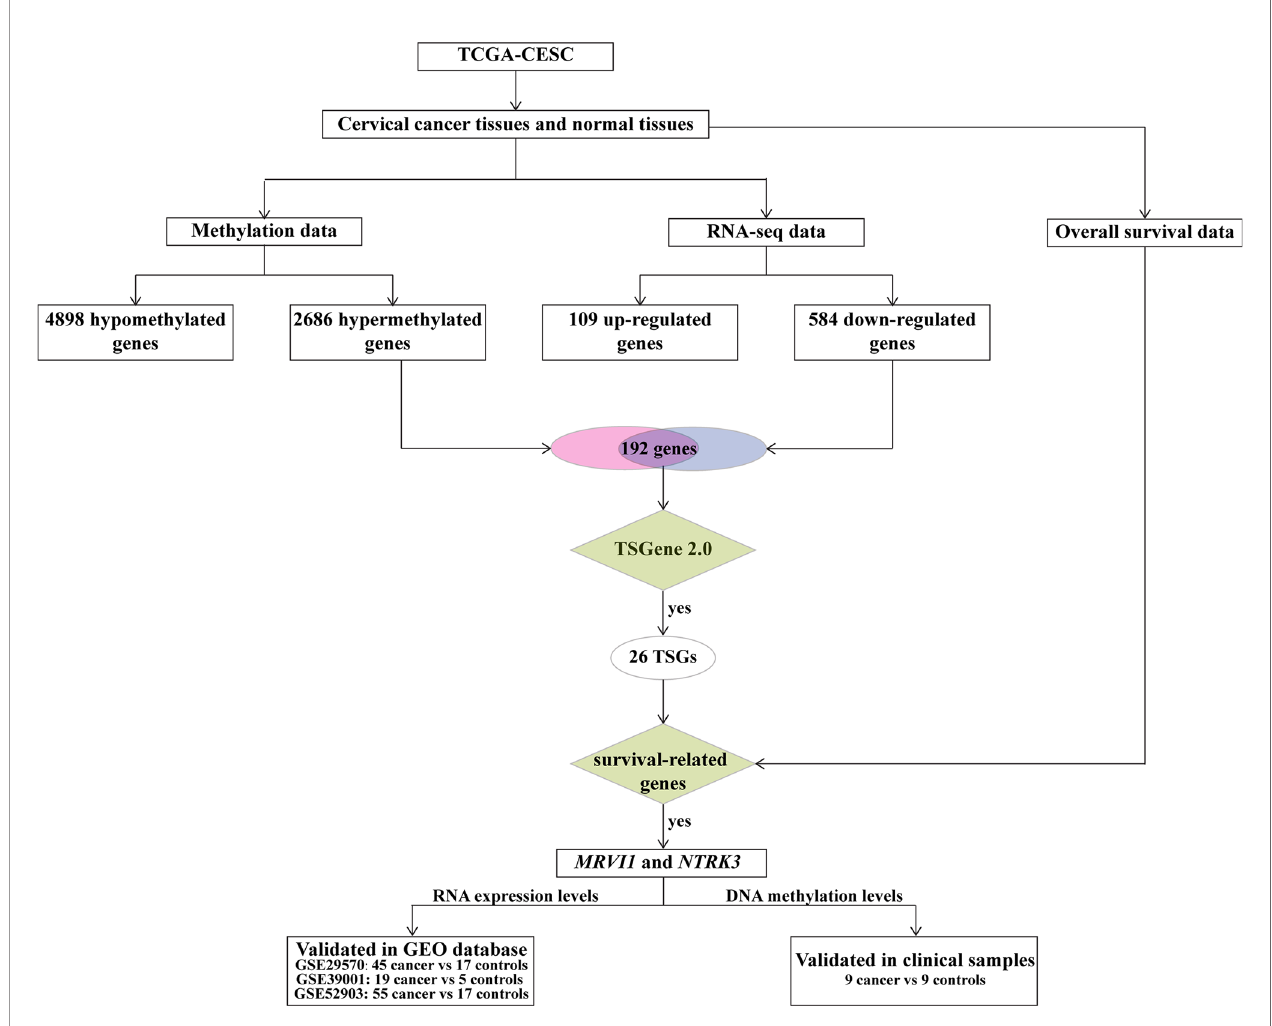
FIGURE 1 | Flow chart of data collection and analysis. TSGs, tumor suppressor